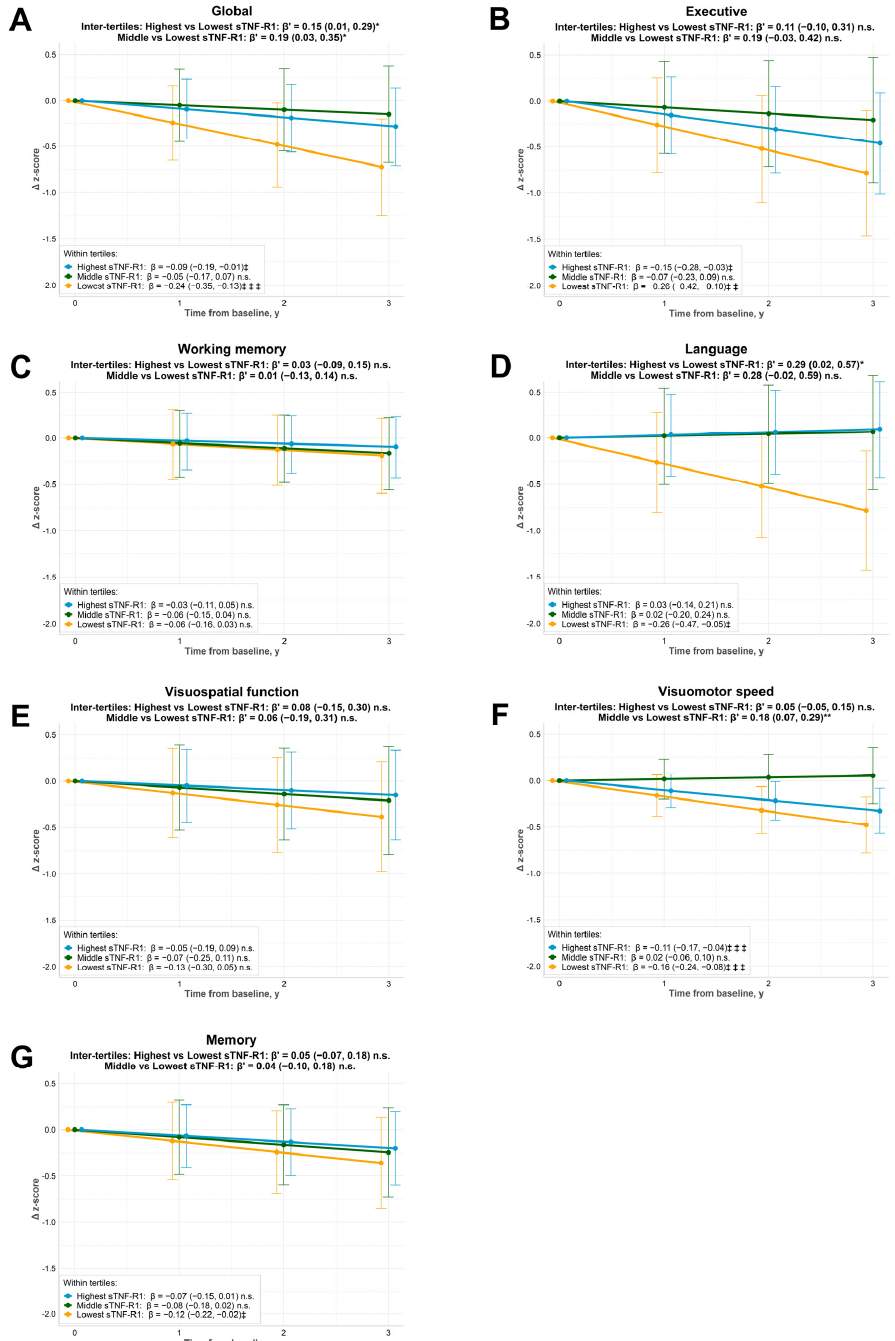
Figure 2. Associations between baseline sTNF-R1 tertiles and the cognitive trajectories of CIND subjects. Estimated mean change in cognitive domain scores ( ∆ z -scores) with 95% CI are stratified by the tertiles of sTNF-R1 (yellow: lowest tertile ( n = 30), green: middle tertile ( n = 27), blue: highest tertile ( n = 46)) for ( A ) global cognition as well as ( B – G ) each of the six cognitive domains (see Section 2.3 on neuropsychological battery). β -coefficients with 95% CIs are derived from linear mixed- effect models adjusted for age, education, gender, APOE4 carrier status, hypertension, diabetes mellitus, cardiovascular disease and hyperlipidemia. Interpretation: Within tertiles, β represents the decline in cognitive z -scores over time for each tertile of sTNF-R1; ‡ p < 0.05, ‡‡ p < 0.01, ‡‡‡ p < 0.001, n.s.: not significant. Between tertiles, β ’ represents the difference in the rate of change in cognitive z -scores between the highest/middle tertiles of sTNF-R1 vs. the lowest sTNF-R1 tertile; * p < 0.05, ** p < 0.01, n.s.: not significant. CIND = cognitive impairment, no dementia; n = number of